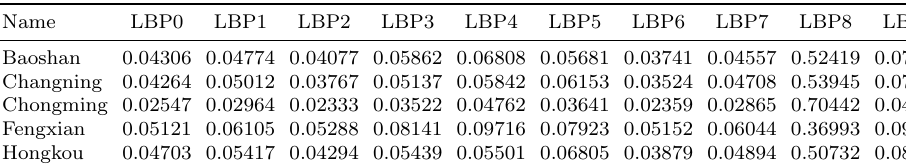
Table 8: Partial texture features identified in